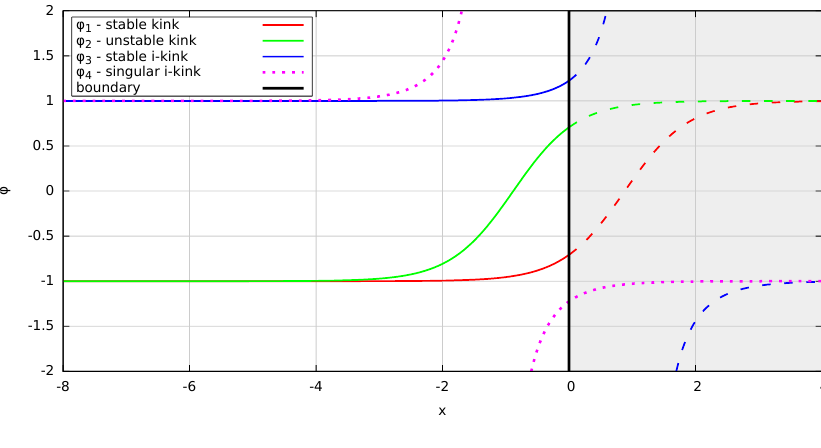
Figure 1 . Static solutions for H = 1 =